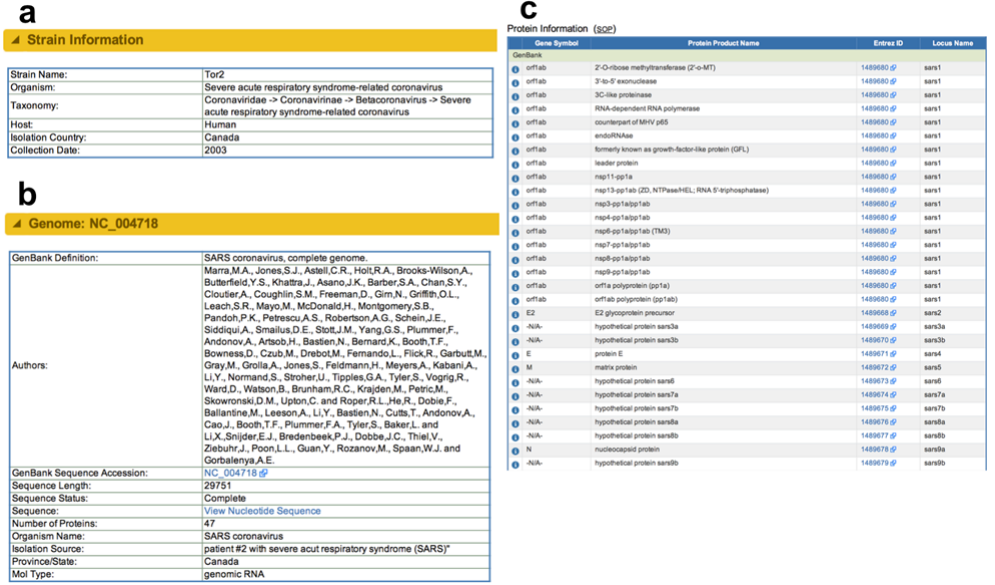
Figure 2. Strain and Genome Information in ViPR. The relevant strain- and genome-level annotations for the SARS-CoV Tor2 strain are parsed from the corresponding GenBank file and organized into intuitive categories for display on the ViPR Strain Details page. (a) Strain-level information includes strain name, virus taxonomy and host, country, and date of specimen isolation. (b) Information at the genome level comprises publication information, GenBank accession number, sequence length, nucleotide sequence of the genome, number of annotated proteins, and molecule type. (c) Annotated gene symbols, protein product names, Entrez ID and locus name for each gene in the genome are similarly parsed from the GenBank record and displayed in a tabular